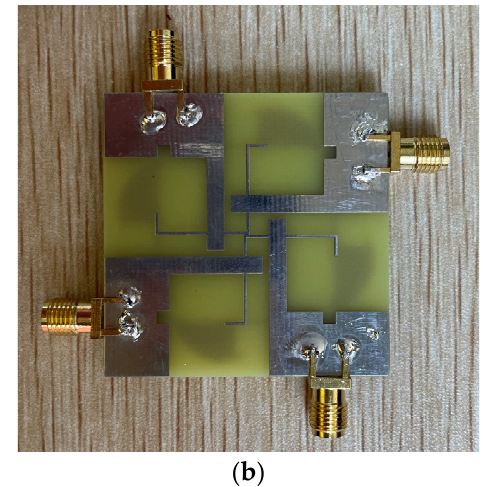
Figure 7. Photograph of the fabricated antenna: ( a ) top; ( b ) bottom.